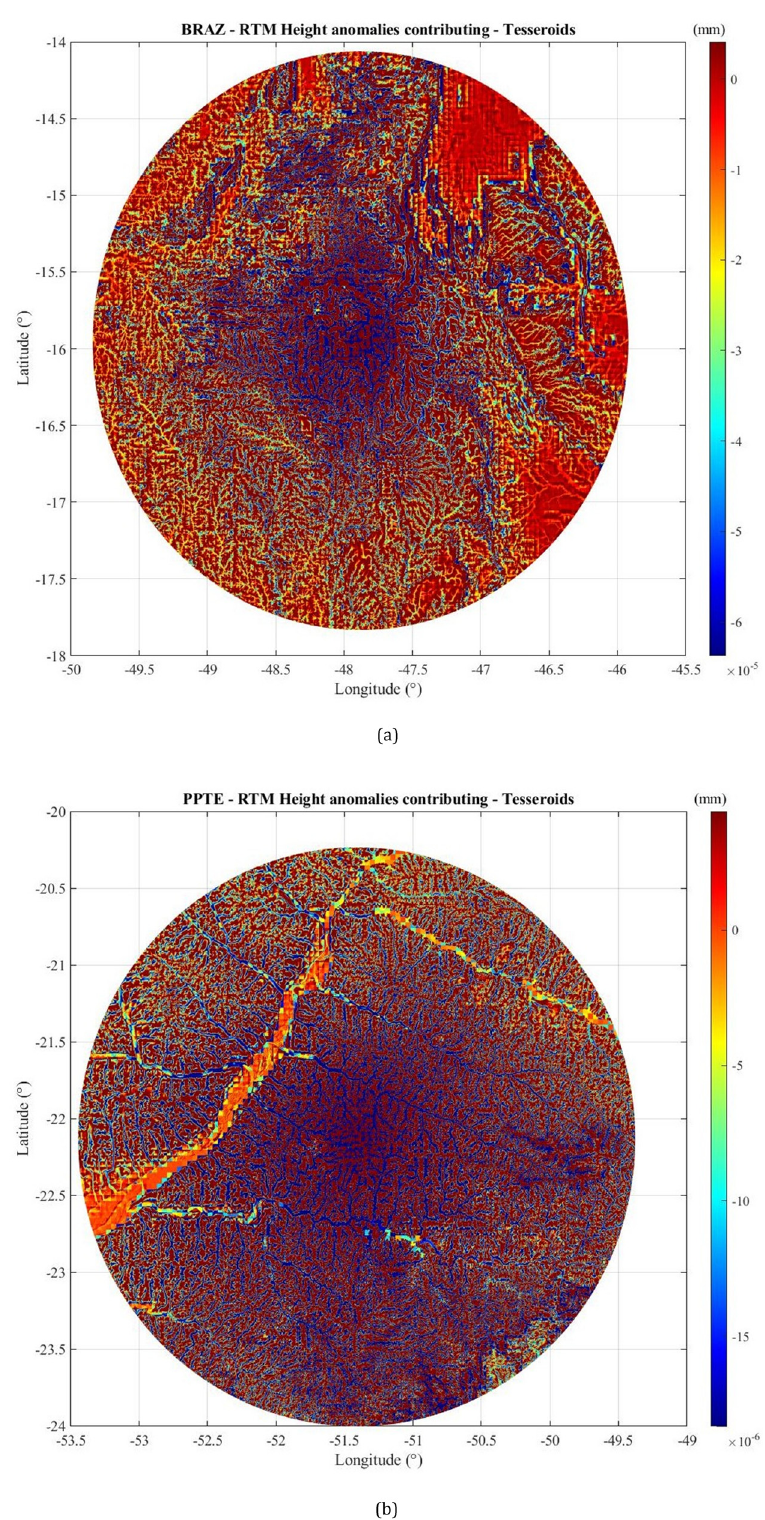
Figure 11: Example of RTM height anomaly contributions using tesseroid approach and CRUST 1.0 at ( a ) BRAZ and ( b ) PPTE